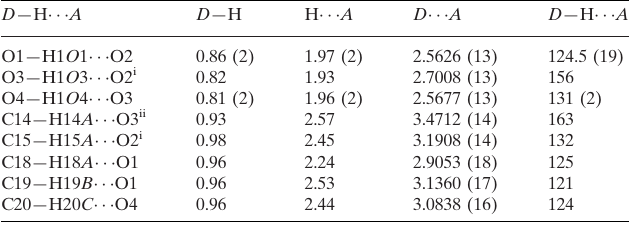
Hydrogen-bond geometry (A˚ , (cid:5)